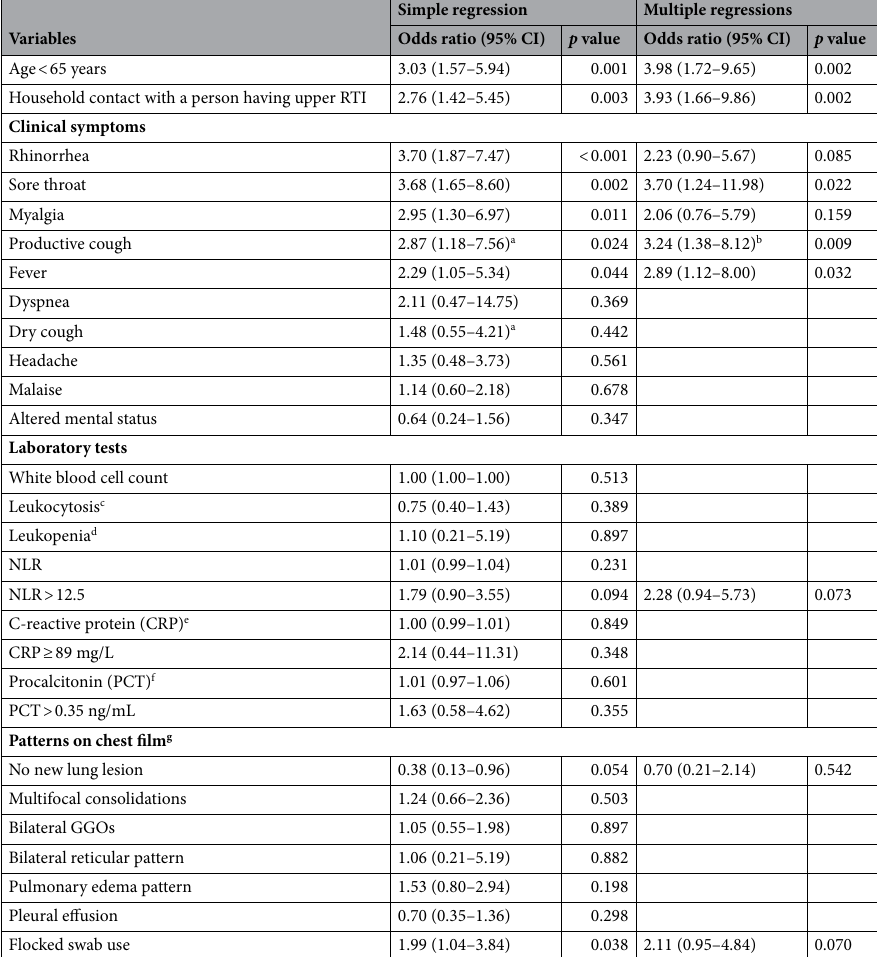
Table 2. Simple and multivariable regressions for factors associated with viral respiratory tract infections. CI confidence interval, RTI respiratory infection, NLR neutrophil-to-lymphocyte ratio. a Compared to no cough.